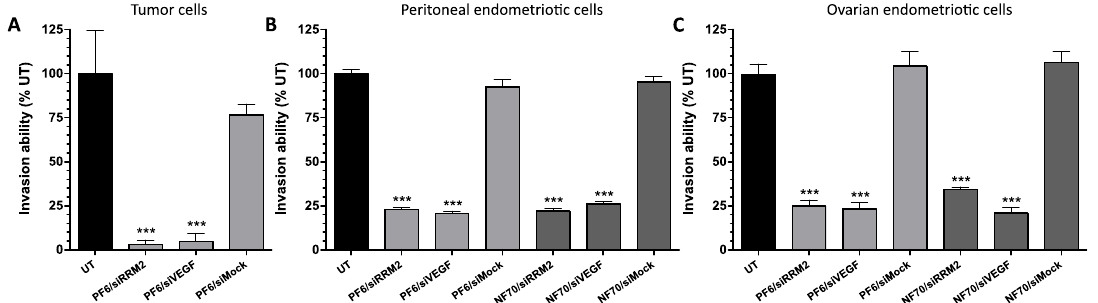
Figure 3. Therapeutic CPP/siRNA NPs reduced cell invasiveness. Invasive capability of ( A ) U-87MG, endometriotic ( B ) peritoneal, and ( C ) ovarian cells through the extracellular matrix. Cells were transferred into Matrigel invasion chambers 48 h after transfection, followed by a 24 h attachment period and a 24 h chemoattraction to FBS. Invaded cells were counted under inverted microscope and results were normalized to UT cells. Data were collected from 3 individual experiments. Error bars represent SEM. *** p < 0.001, one-way ANOVA, Tukey post hoc. UT, untreated; FBS, fetal bovine serum.